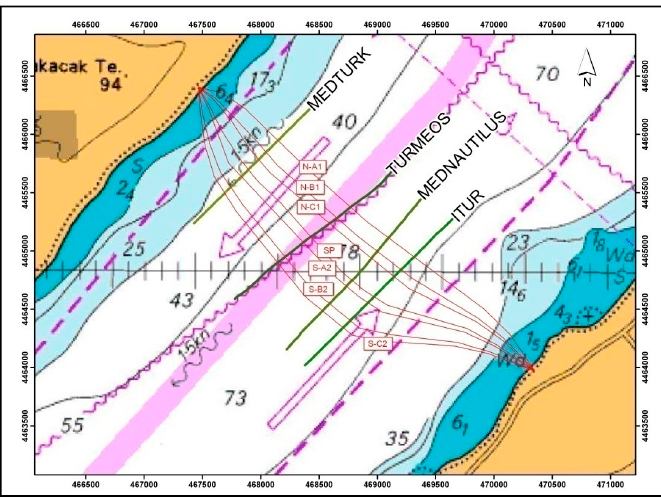
Figure 14. Plan view of cable crossings due to the in-service telecommunication cables (ITUR, MEDNAUTILUS, TURMEOS, and MEDTURK).